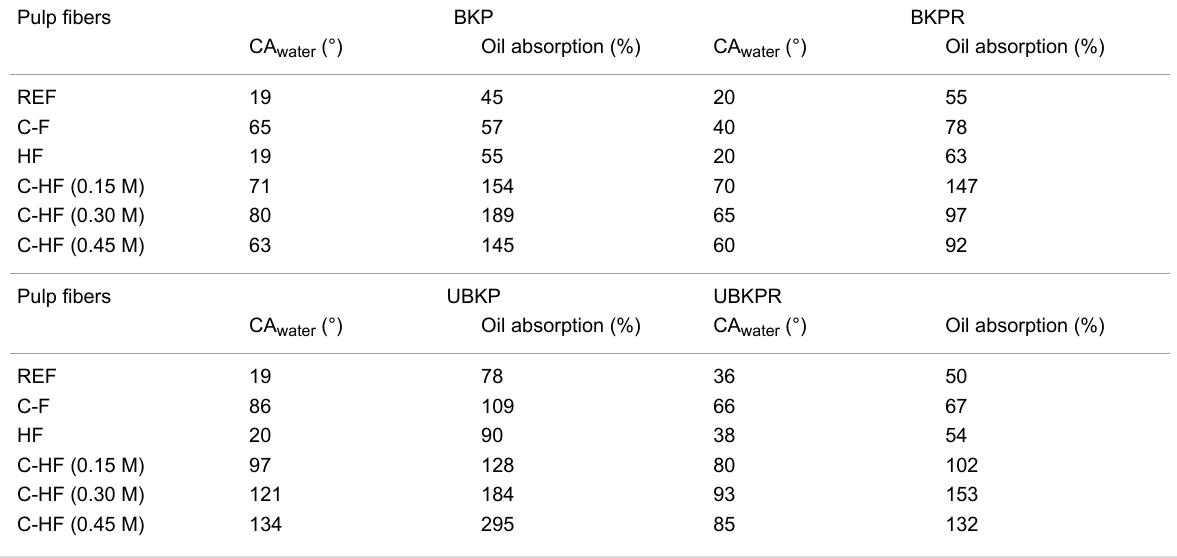
Table 3: Water contact angle and oil absorption values of the pulp fibers.